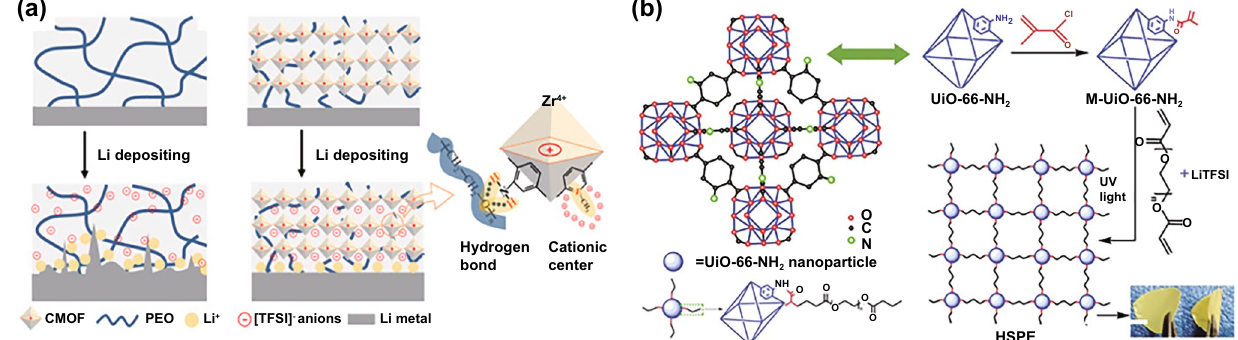
Fig. 8 a Li plating behavior with PEO-LiTFSI and PEO-LiTFSI@CMOF [101]. Copyright 2019, Elsevier. b Synthesis process of the PEGDA-